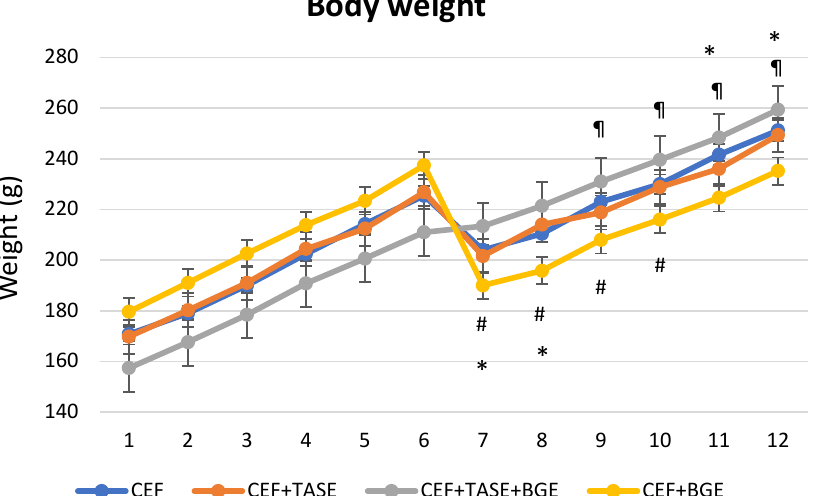
Figure 2. Weight monitoring during experiment (12 days). On day 6, the bacterial inoculum was introduced. CEF = ceftriaxone (* p < 0.05). CEF + TASE = ceftriaxone + thiosulfinate-enriched Allium sativum extract. CEF + TASE + BGE = ceftriaxone + thiosulfinate-enriched extract + black garlic extract ( ¶ p < 0.05). CEF + BGE = ceftriaxone + black garlic extract (# p < 0.05). Mean ± SEM.